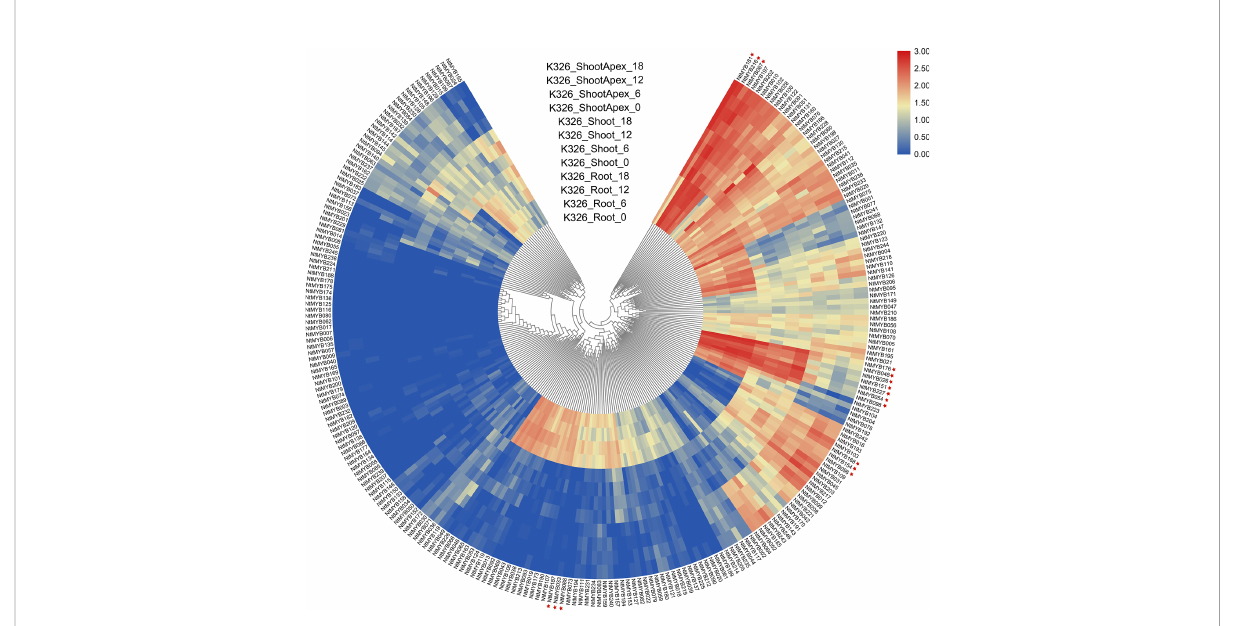
FIGURE 4 Expression pro fi les of the NtMYB genes in three different tissues (root, shoot, and shoot apex). The heatmap was constructed based on the transcriptome data of NtMYB genes and visualized by R.